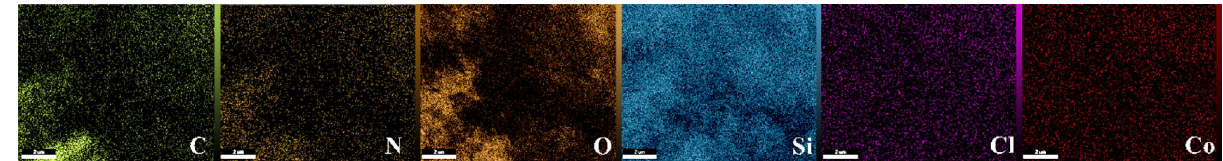
Figure 5. The elemental mapping of GO/f-SiO 2 /Co.